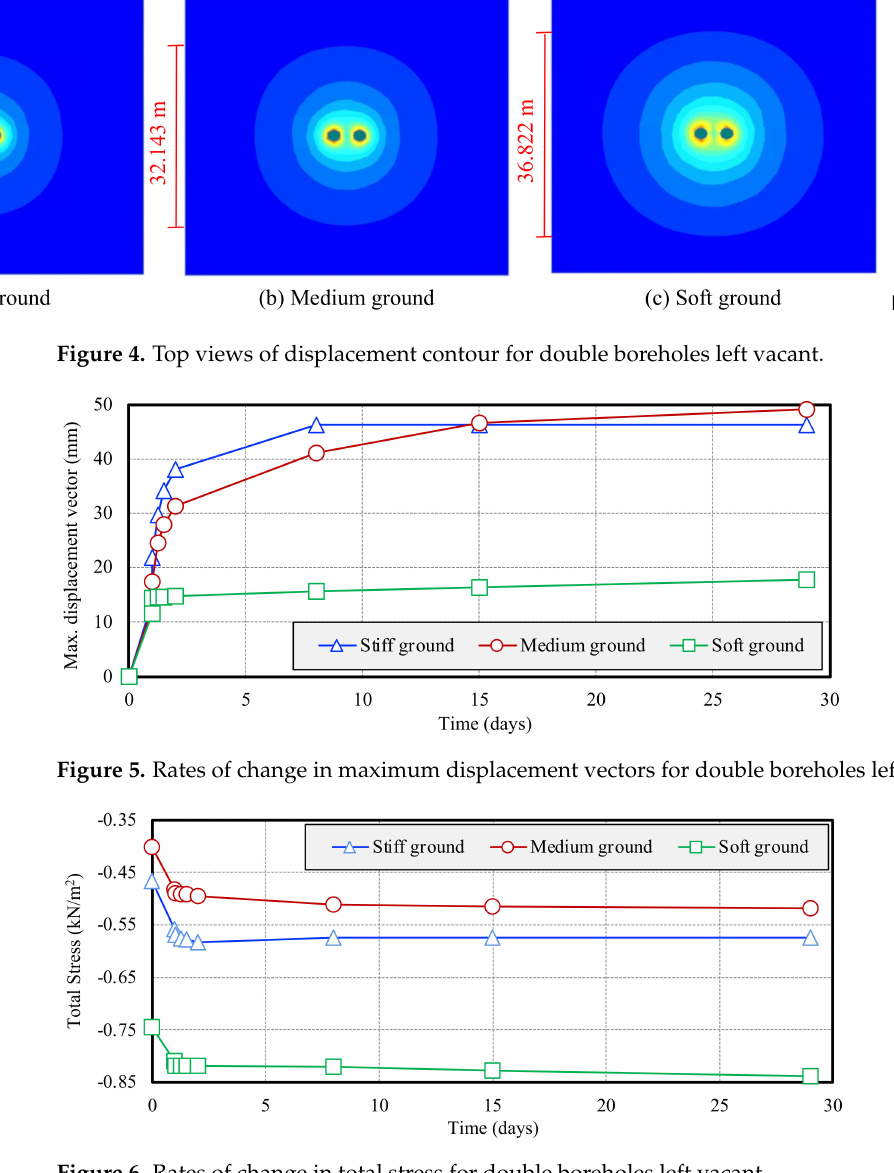
Figure 6. Rates of change in total stress for double boreholes left